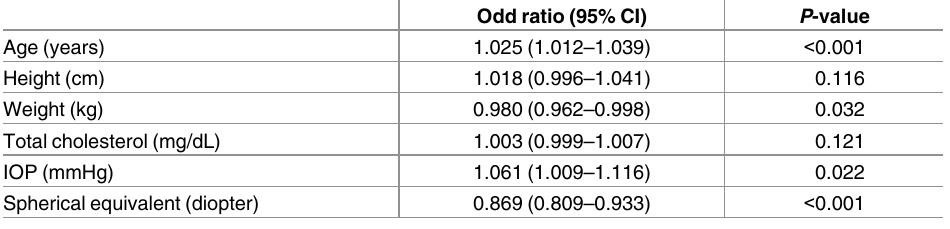
Table 7. Multivariate regression analysis for systemicand ocular parameters of glaucomatous retinal nerve fiber layer defect (RNFLD) group, using the non-glaucomatous-RNFLD group as a